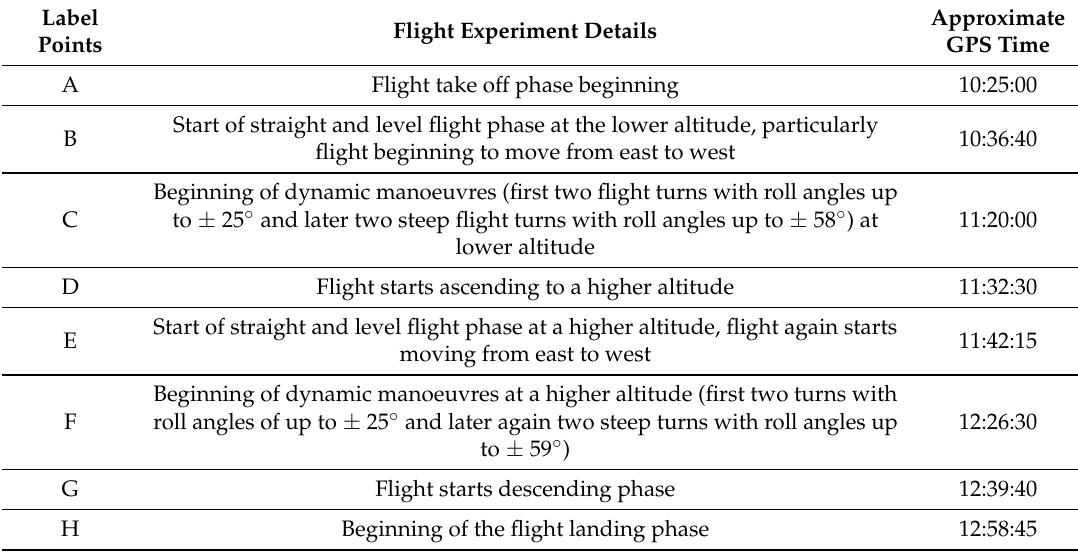
Figure 4. Airborne trajectory at heights of about 650 and 2800 m in ( a ) and ( c ), respectively. Dynamic manoeuvre segments corresponding to the different heights in ( b ) and ( d ), respectively. For details of the marked points, cf. Table 3. Map presentations taken from [26]. Table 3. Details of marked points on the flight trajectory